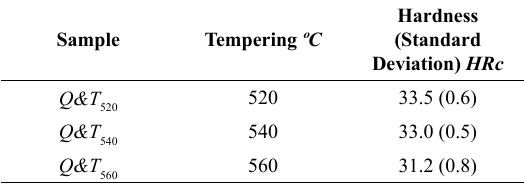
Table 4. Hardness measurement for mid-thickness samples which were not submitted to solution treatment. Average and standard deviation for 3 indentations.